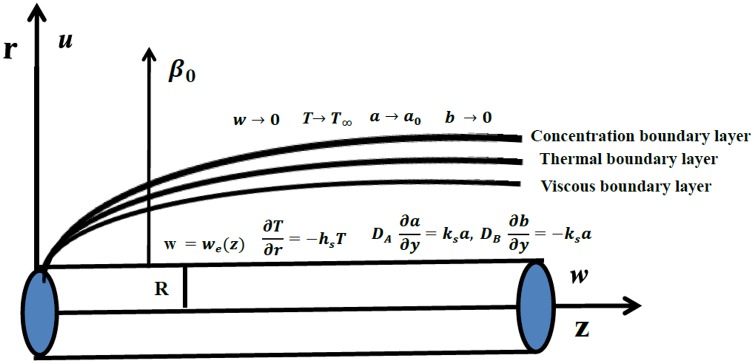
Geometry of problem.